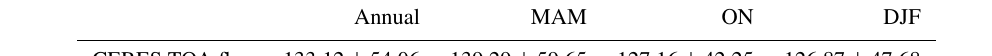
Table 1. Annual and seasonal mean CERES TOA flux measurements and difference between AS RAD TOA and CERES TOA in Wm − 2 .